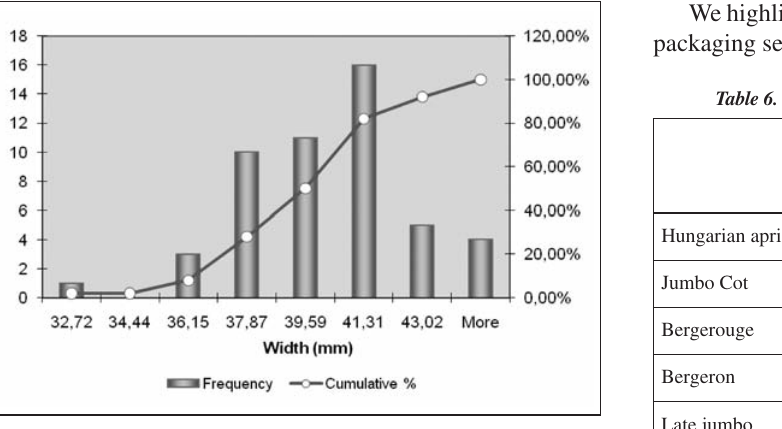
Fig. 36: Distribution of width values of category B of Late Jumbo apricot